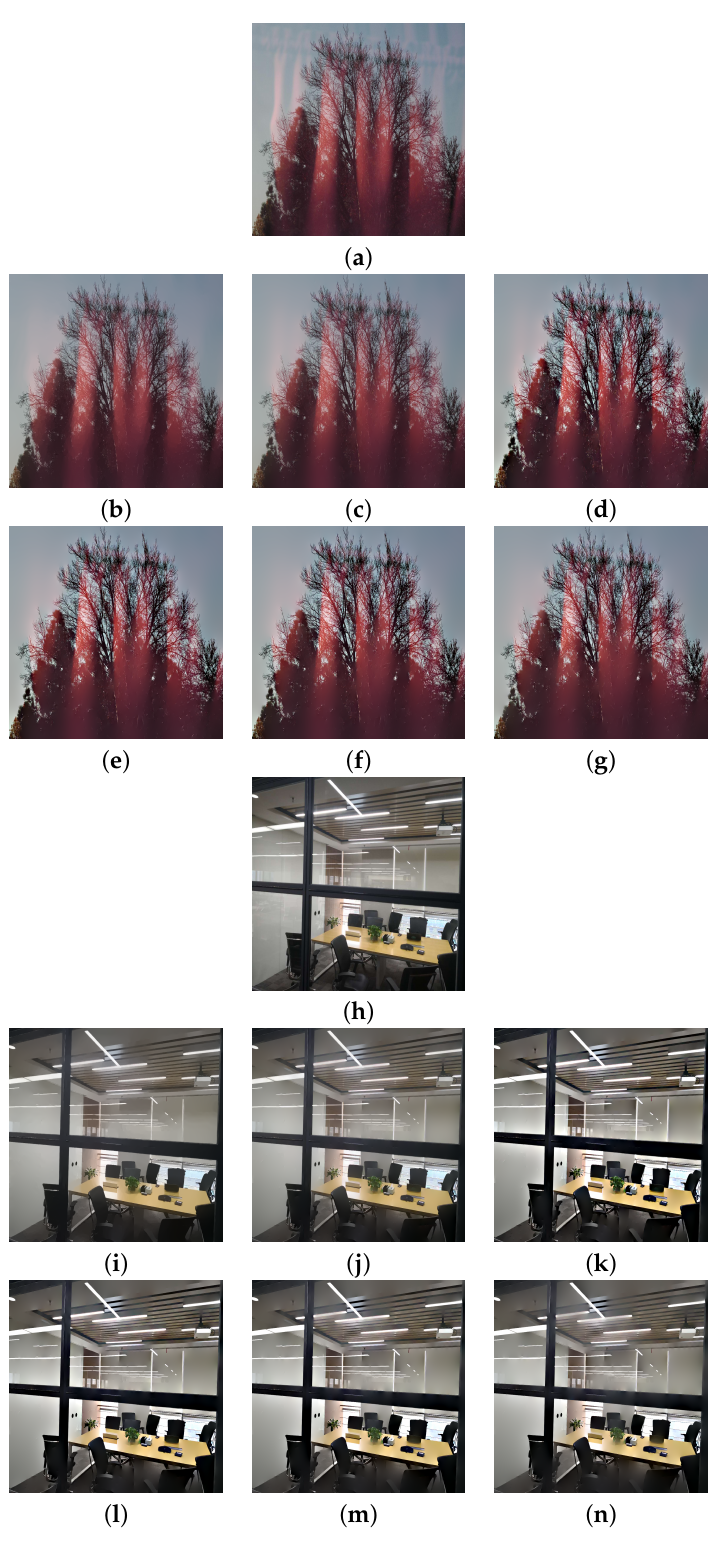
Figure 7. Reflection suppression results for real glass images ‘Tree’ and ‘Office’. ( a , h ) Input images. ( b , i ) The results of algorithm [2]. ( c , j ) The results of algorithm [3]. ( d , k ), ( e , l ), ( f , m ), and ( g , n ) are results of the proposed algorithm with N = 1,2,3,4,